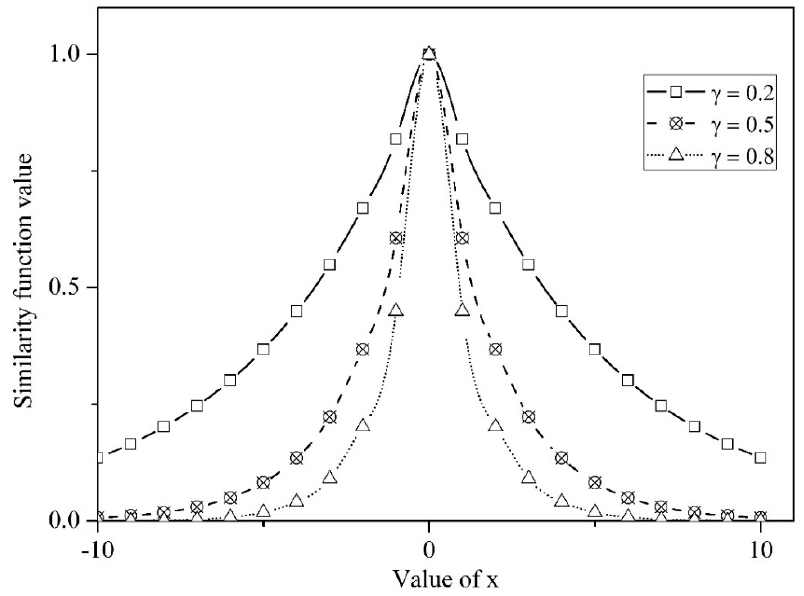
Figure 5. Effect of the free parameter γ on the estimation of similarity.